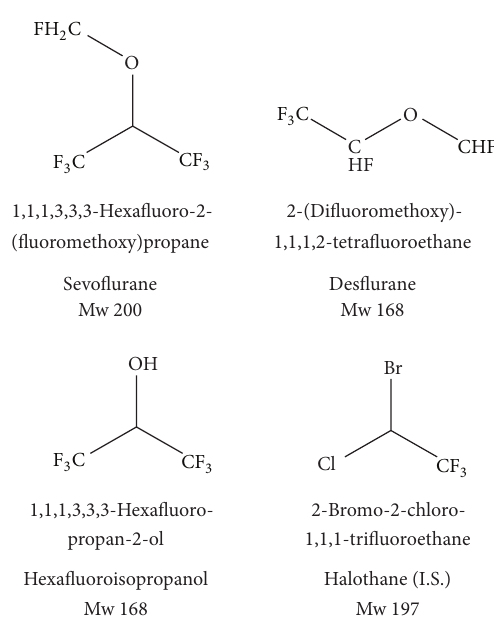
boiling point: 331.75 K at 101.3 kPa and density 1.5 × 10 3 kg/m 3 at 293 K; desflurane, boiling point: 296.65 K at 101.3 kPa and density 1.5 × 10 3 kg/m 3 at 293 K; HFIP, boiling point: 332 K at 3 3 101.3 kPa and density 1.6 × 10 kg/m at 293 K), pure